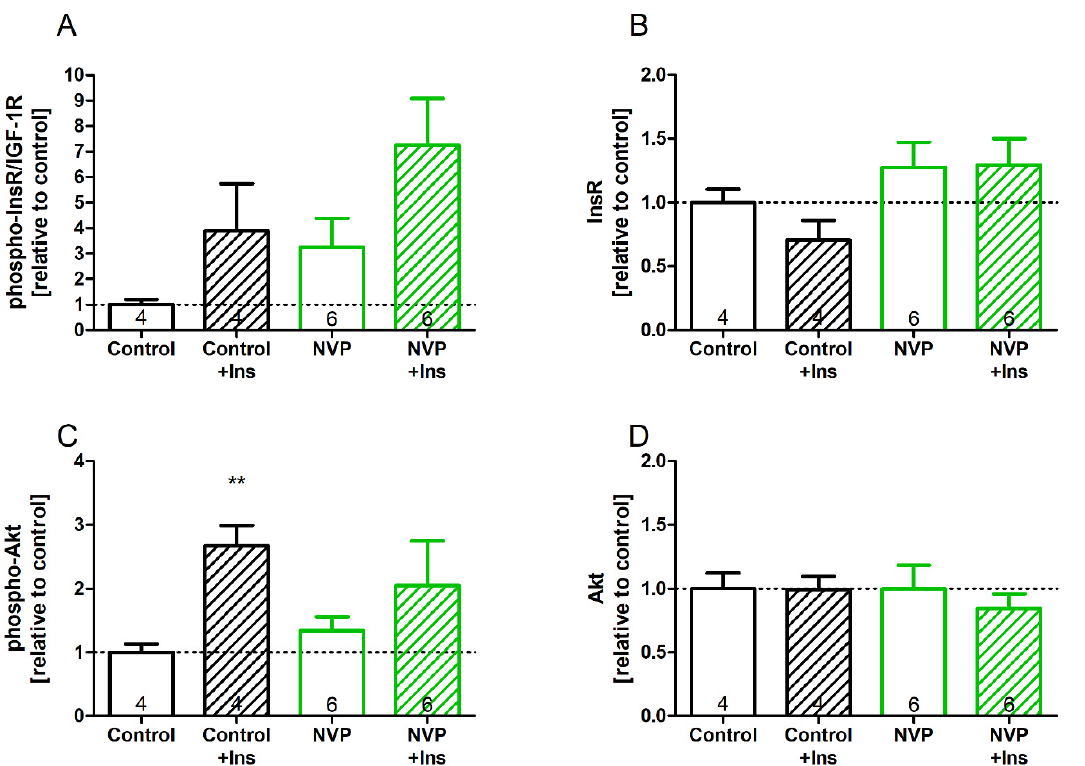
Figure 4. Cardiac insulin signaling after two weeks of NVP-AEW541 treatment: Phosphorylation of InsR/IGF-1R ( A ) and downstream signaling protein Akt ( C ), as well as total protein expression of insulin receptor (InsR) ( B ) and Akt ( D ) with and without insulin stimulation (+Ins). Data are mean ± SEM, n = 4–6 per group as indicated in the bars. Significant differences ** p < 0.01 vs.